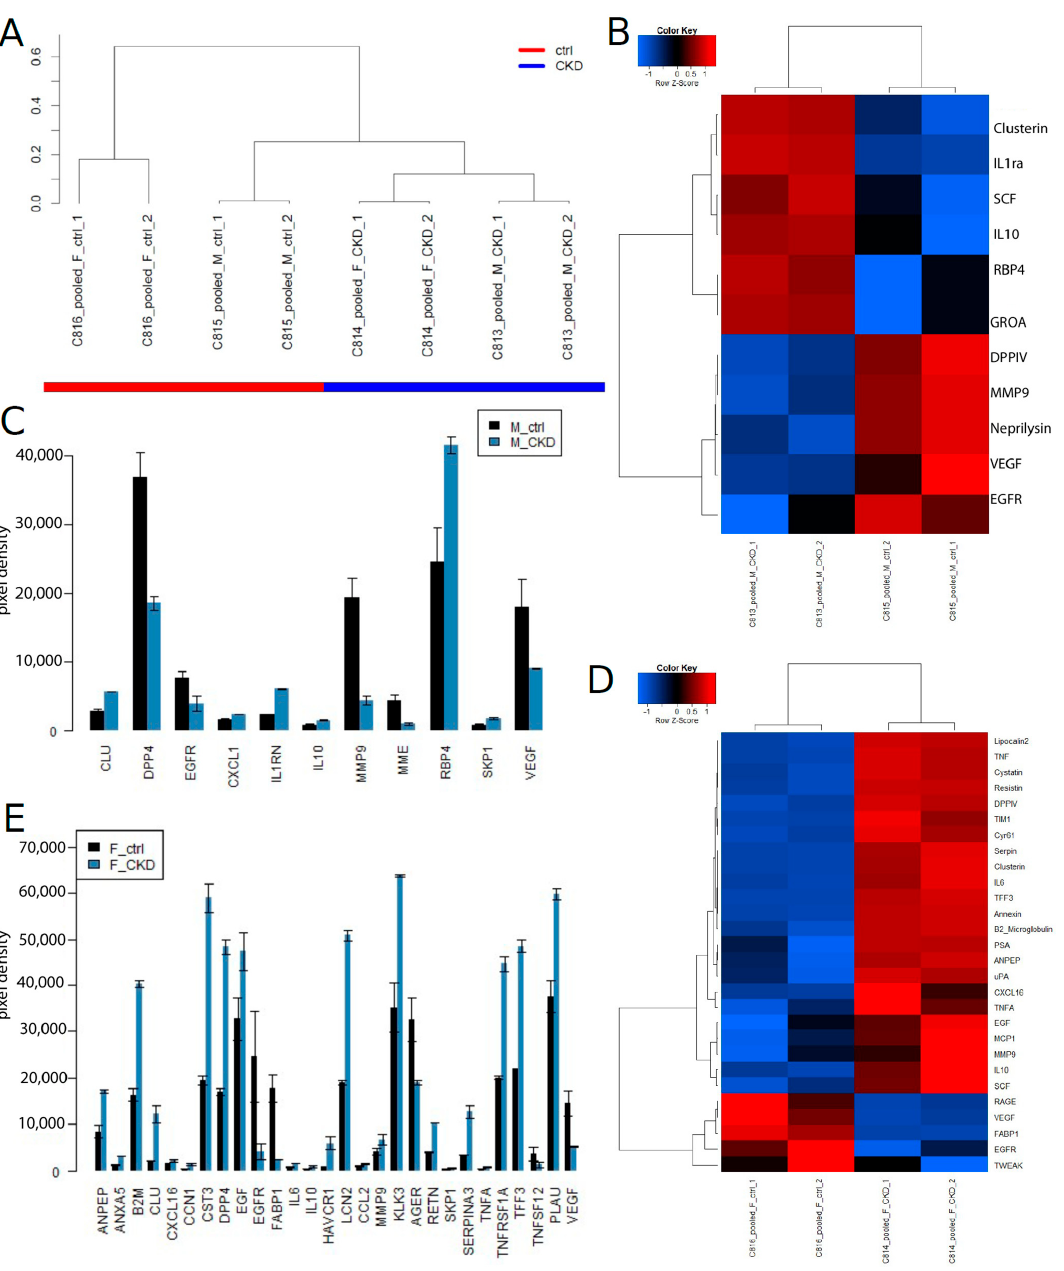
Figure 2. CKD biomarkers identified on the Human Kidney Biomarker Array in experiment series 1. ( A ) Experiments cluster into CKD and healthy control based on the global kidney cytokine expression. ( B ) Heatmap and ( C ) barplot of markers in males (M) that were up ‐ regulated (up): CLU, CXCL1, IL1RN, IL10, RBP4 and SKP1, and down ‐ regulated (down): DPP4, EGFR, MME, MMP9 and VEGF. ( D ) Heatmap and ( E ) barplot of markers in females (F) that were up ‐ regulated (up): ANPEP, ANXA5, B2M, CCL2, CCN1, CLU, CXCL16, CST3, DPP4, EGF, IL6, IL10, HAVCR1, KLK3, LCN2, MMP9, PLAU, RETN, SERPINA3, SKP1, TNFA, TNFSRF1A and TTF3, and down ‐ regulated (down): AGER, EGFR, FABP1 and VEGF.